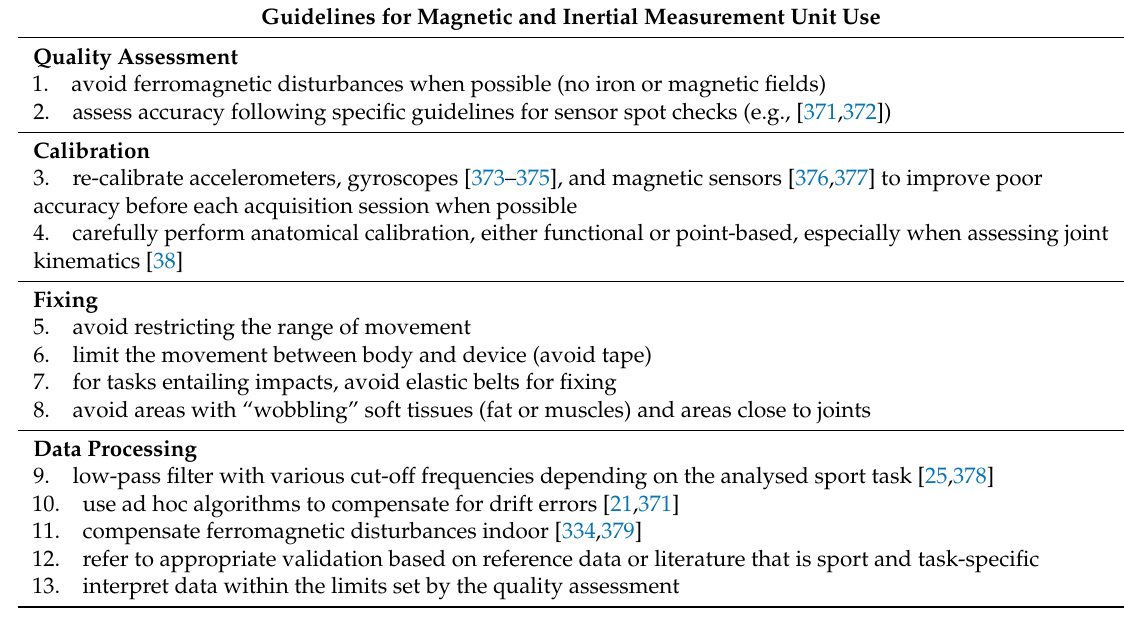
Table 7. Guidelines for Magnetic and Inertial Measurement Unit quality assessment, calibration, fixing and data